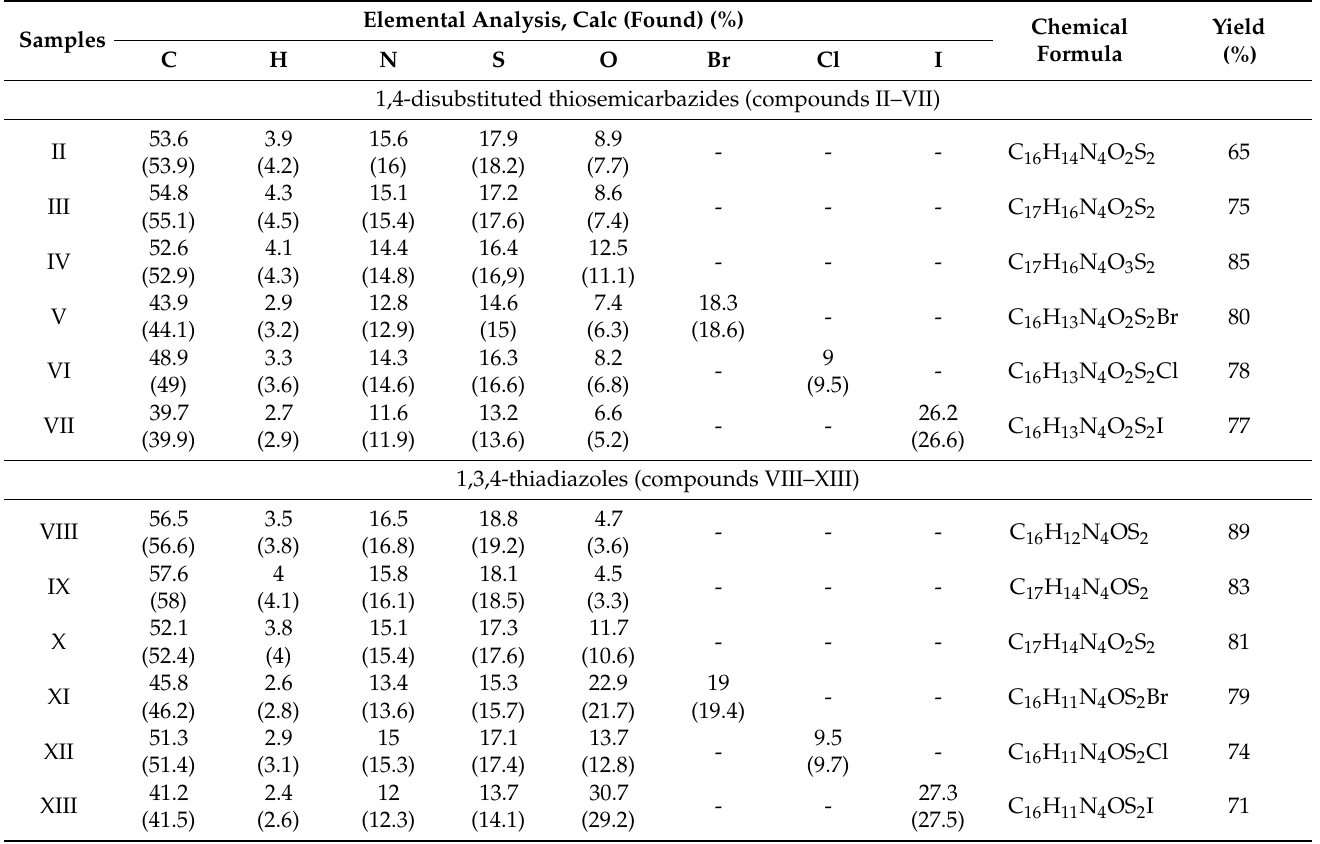
Table 1. Some characteristics of compounds II–XIX.